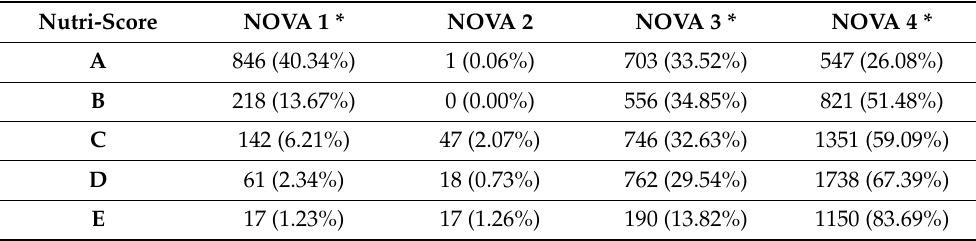
Table 1. Cross-frequency table between Nutri-Score and NOVA classification. Relative frequencies were calculated by rows.